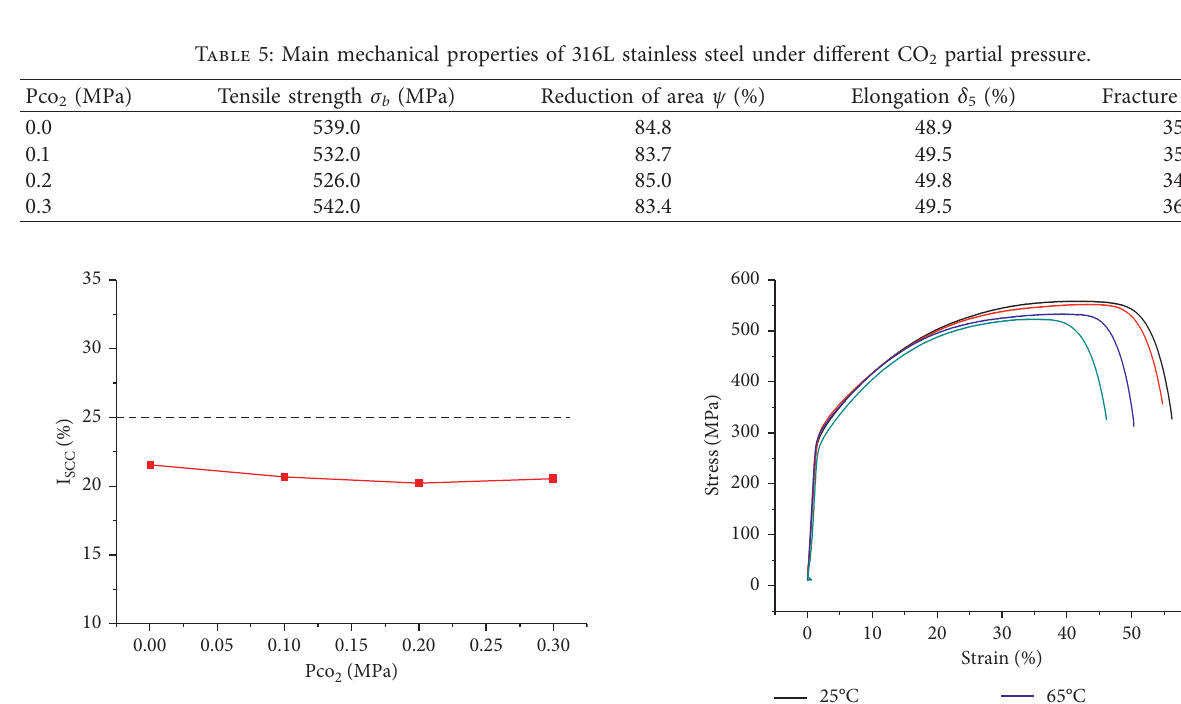
Figure 5: Stress corrosion cracking sensitivity index of 316L stainless steel in different CO 2 partial pressure.